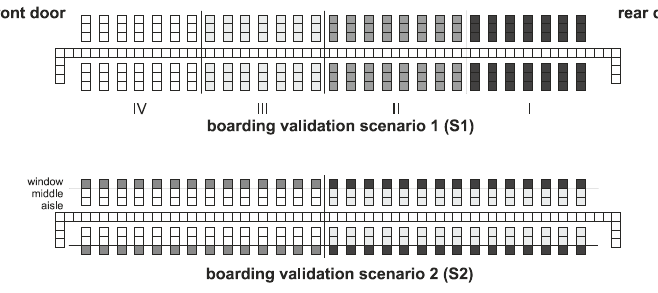
Figure 13. Airline boarding strategies for validation trials: Scenario 1 and Scenario 2 .